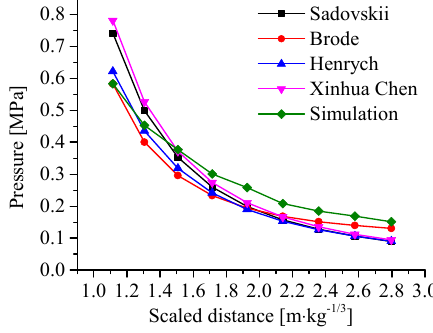
Figure 3. Comparison of theoretical and numerical data of the explosion in air.